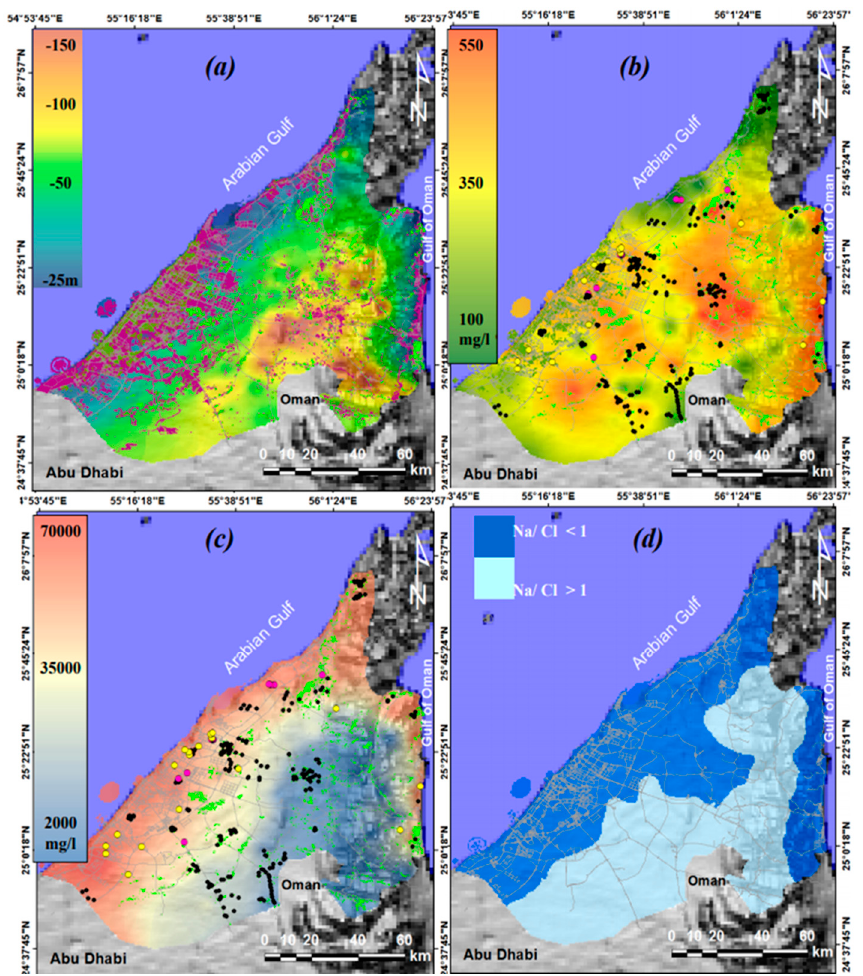
Figure 17. Built-up and vegetation areas draped over the maps of groundwater level ( a ), locations of septic tanks, sewage treatment plants, landfill, and farmland are draped over the maps of NO 3 and TDS for the year 2018 ( b and c ), and map of the Na/Cl ratio showing the area affected by water intrusion in 2018 ( d ).